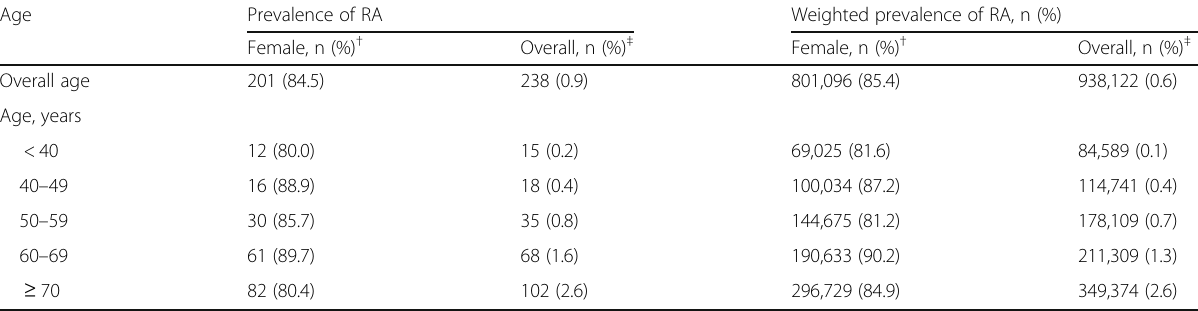
Table 2 Prevalence of rheumatoid arthritis in Korea